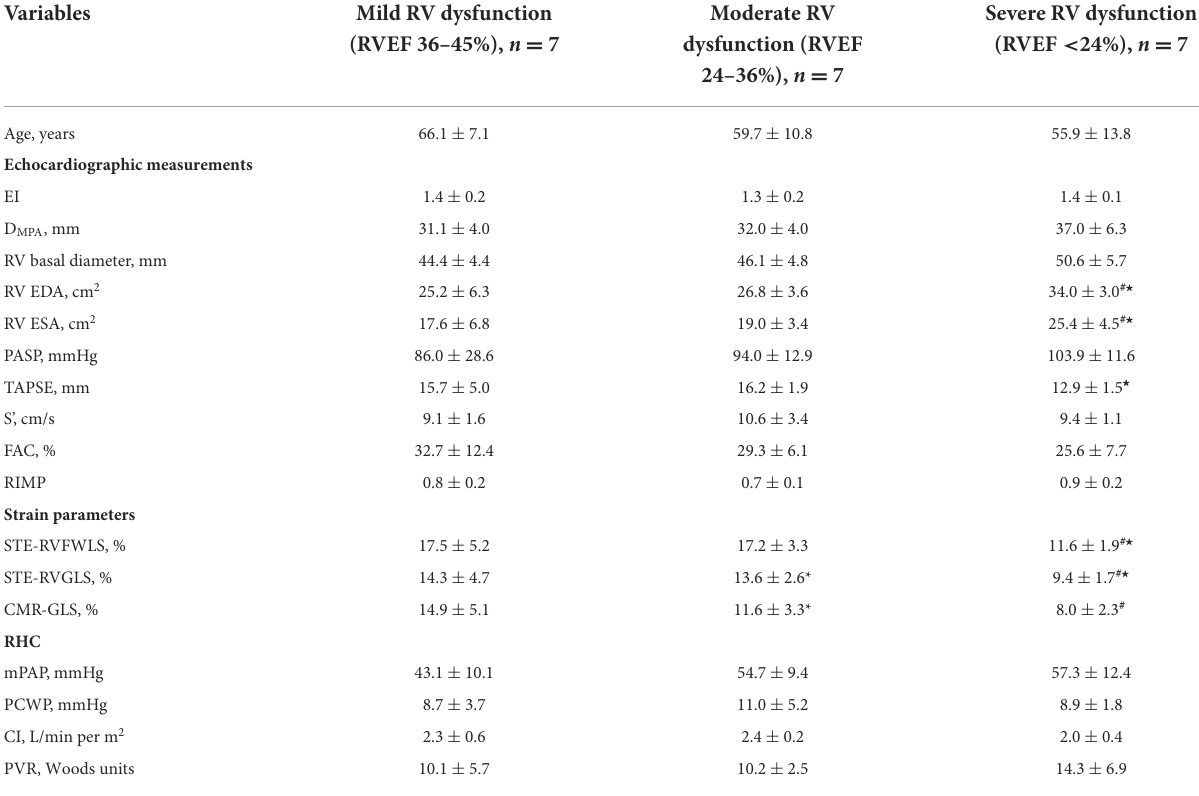
TABLE 2 Comparison of clinical data among CTEPH patients with different degrees of RV